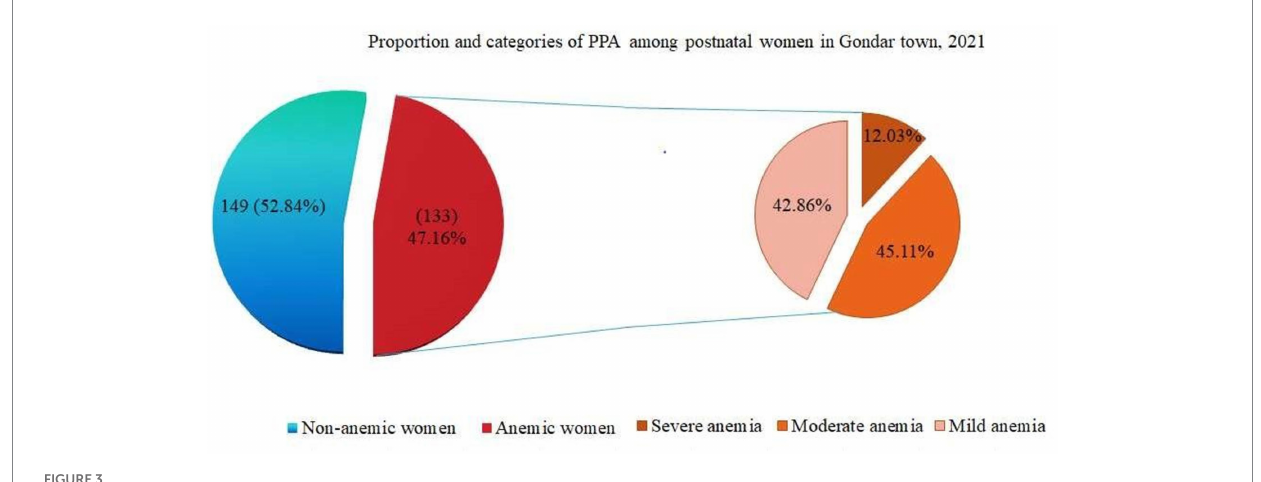
FIGURE 3 Pie of pie chart showing proportion and severity of PPA among postnatal women in Gondar town, 2021 ( n =